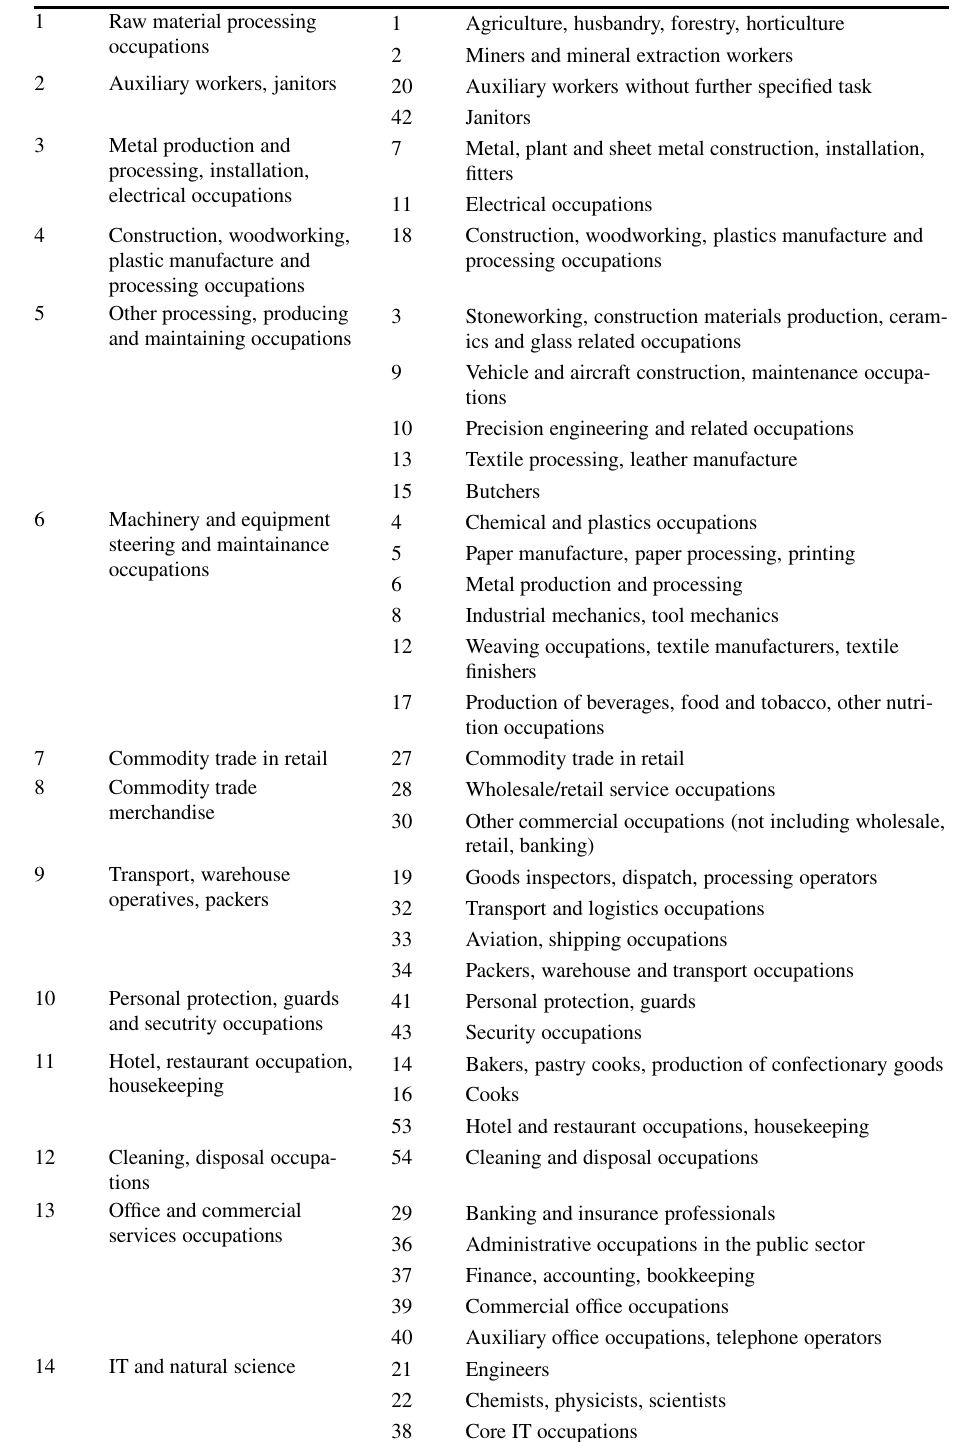
Fields (MOF) and Occupational Fields